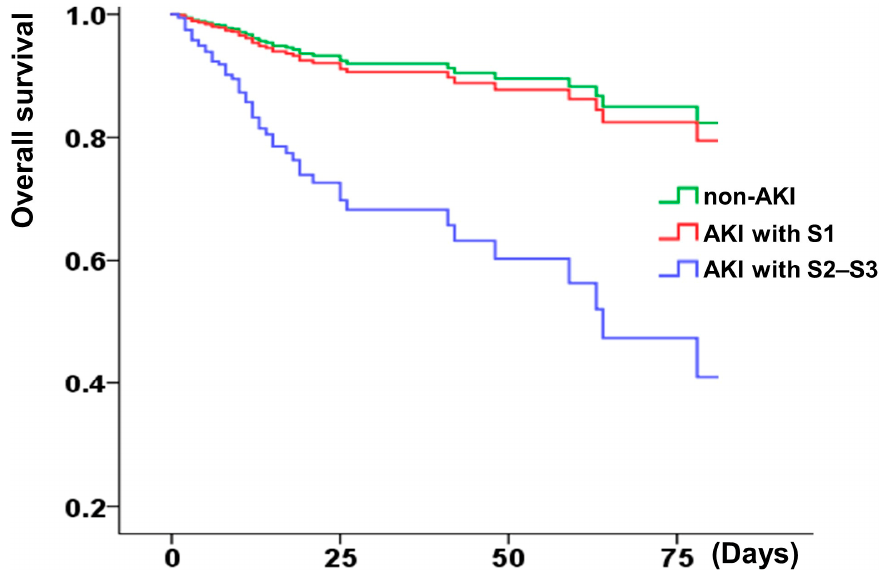
Figure 3. Kaplan–Meier curves display overall survival rate of patients with or without AKI (S1: stage 1; S2–S3: stage 2 or 3). AKI stage 1 as serum creatinine 1.5–1.9 times baseline or ≥ 0.3 mg/dL